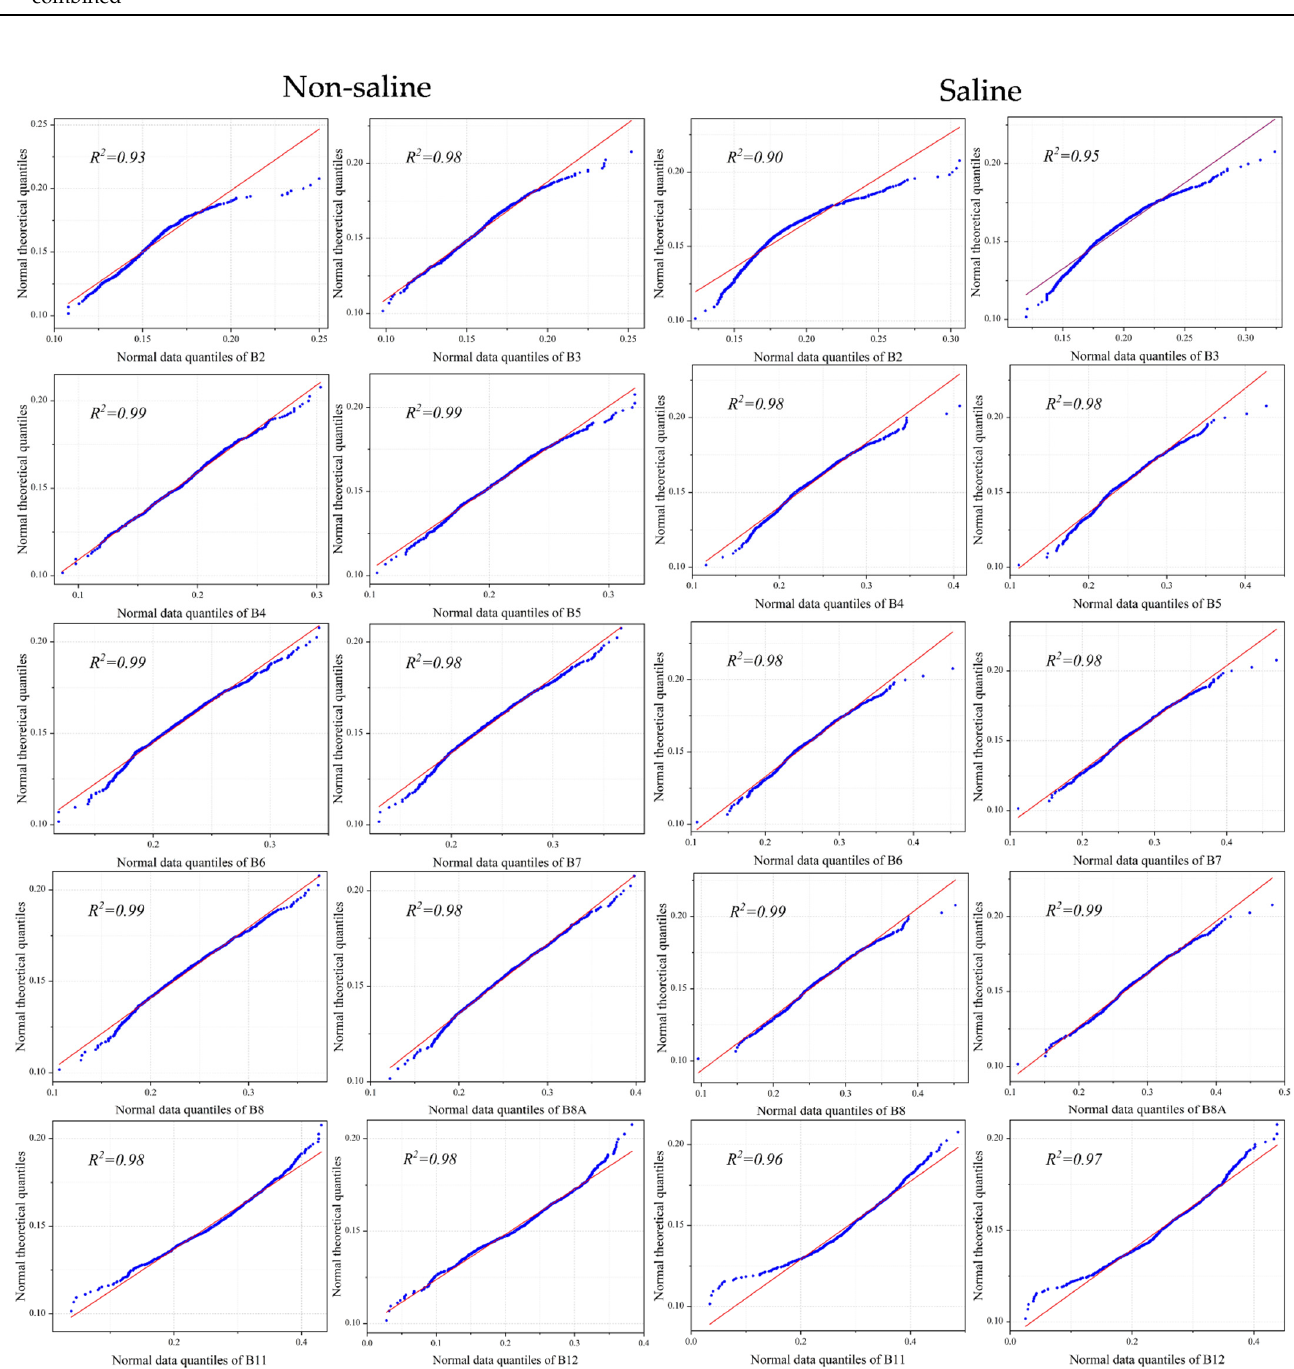
Figure A1. Q-Q test plots for samples’ consistency of different classes on the mean values of the different bands of Sentinel-2 image, which reduced by mean value from March to April 2021.